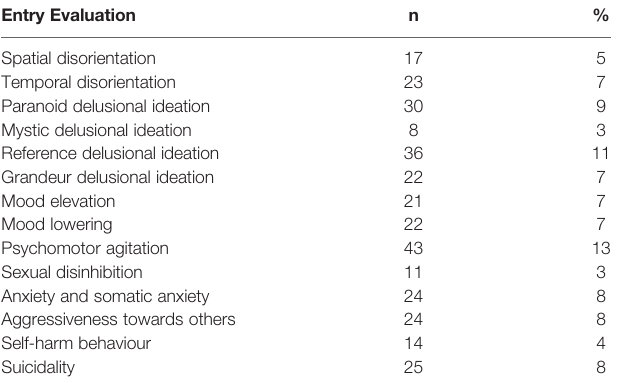
TABLE 3 | Symptoms observed at